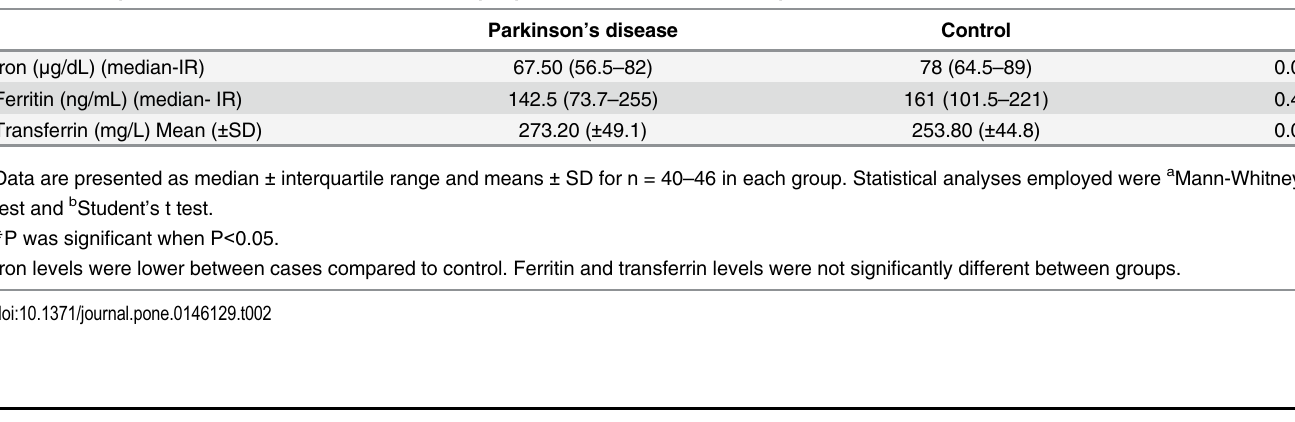
Table 2. Comparison of iron, ferritin, and transferrin peripheral blood levels between patients with Parkinson ’ s disease and